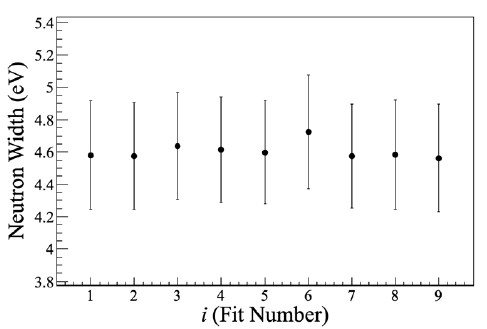
Figure 9. Neutron width of resonance No. 11 for each sample